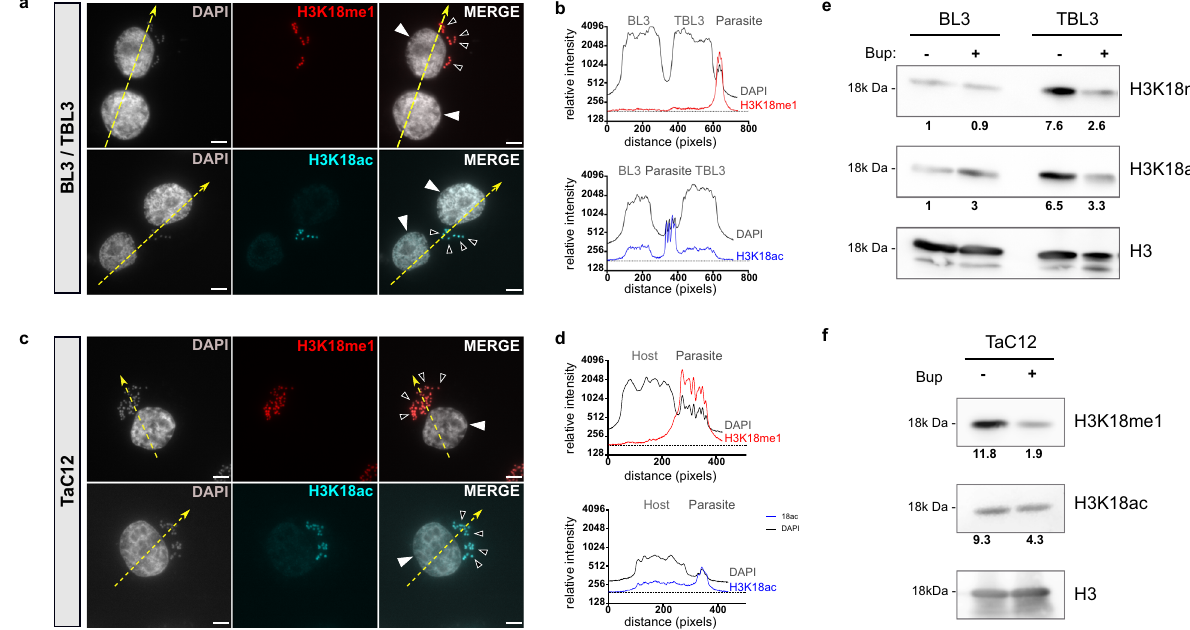
Fig. 1 H3K18 methylation marks parasite nuclei. a Immuno fl uorescence analysis of BL3 (uninfected) mixed with TBL3 (infected) cells. Host and parasite nuclei are stained with DAPI (grey). Histone marks were detected with speci fi c antibodies for H3K18me1 (red) or H3K18ac (cyan). Solid white arrowheads indicate the nuclei of the bovine cells and the smaller empty arrowheads point to parasite nuclei in TBL3 cells only. The yellow dotted arrows indicate the cross-section planes used for quanti fi cation. Scale bar = 5 μ m. b Quanti fi cation of immuno fl uorescence intensity of H3K18me1 (red) and H3K18ac (blue) compared to DNA/DAPI (grey). The plot pro fi les are representative of the yellow cross-section lines. c Immuno fl uorescence staining for H3K18me1 (red) and H3K18ac (cyan) in parasite-infected macrophages (TaC12 cells). Host and parasite nuclei are stained with DAPI (grey). Leica microscope, ×100, Scale bar = 5 μ m. Solid white arrowheads show the bovine host nuclei and empty arrowheads point to parasitic nuclei. The yellow dotted arrows indicate the cross-section planes used for quanti fi cation. d Quanti fi cation of immuno fl uorescence intensity of H3K18me1 (red) and H3K18ac (blue) compared to DNA (grey). The plot pro fi les are representative of the yellow cross-section lines. e Western blot analysis of BL3 and TBL3 cells (treated with the theilericidal drug Buparvaquone, Bup). H3 was used as a loading control. The bands were quanti fi ed and compared with uninfected BL3 cells. Results are representative of at least three independent experiments. f Western blot analysis of H3K18 modi fi cations in infected TaC12 macrophages treated with or without Buparvaquone (Bup). The bands were quanti fi ed and compared with uninfected BL3 cells. Results are representative of at least three independent experiments. All these experiments were performed three times independently with similar results; representative experiments are shown. Full scans blot and immuno fl uorescence replicates are included in the Source Data fi